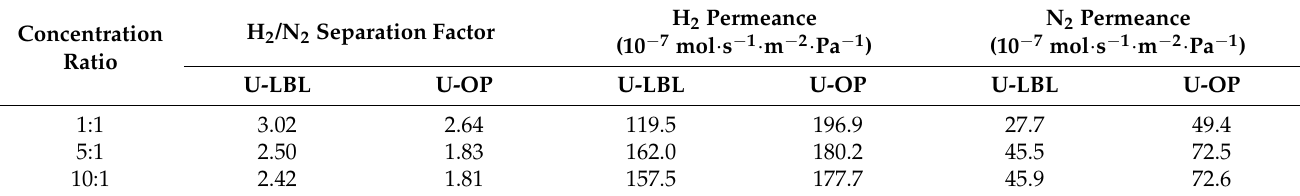
Table 1. H 2 /N 2 separation factor and H 2 and N 2 permeance values of the two membranes tested in gas separation